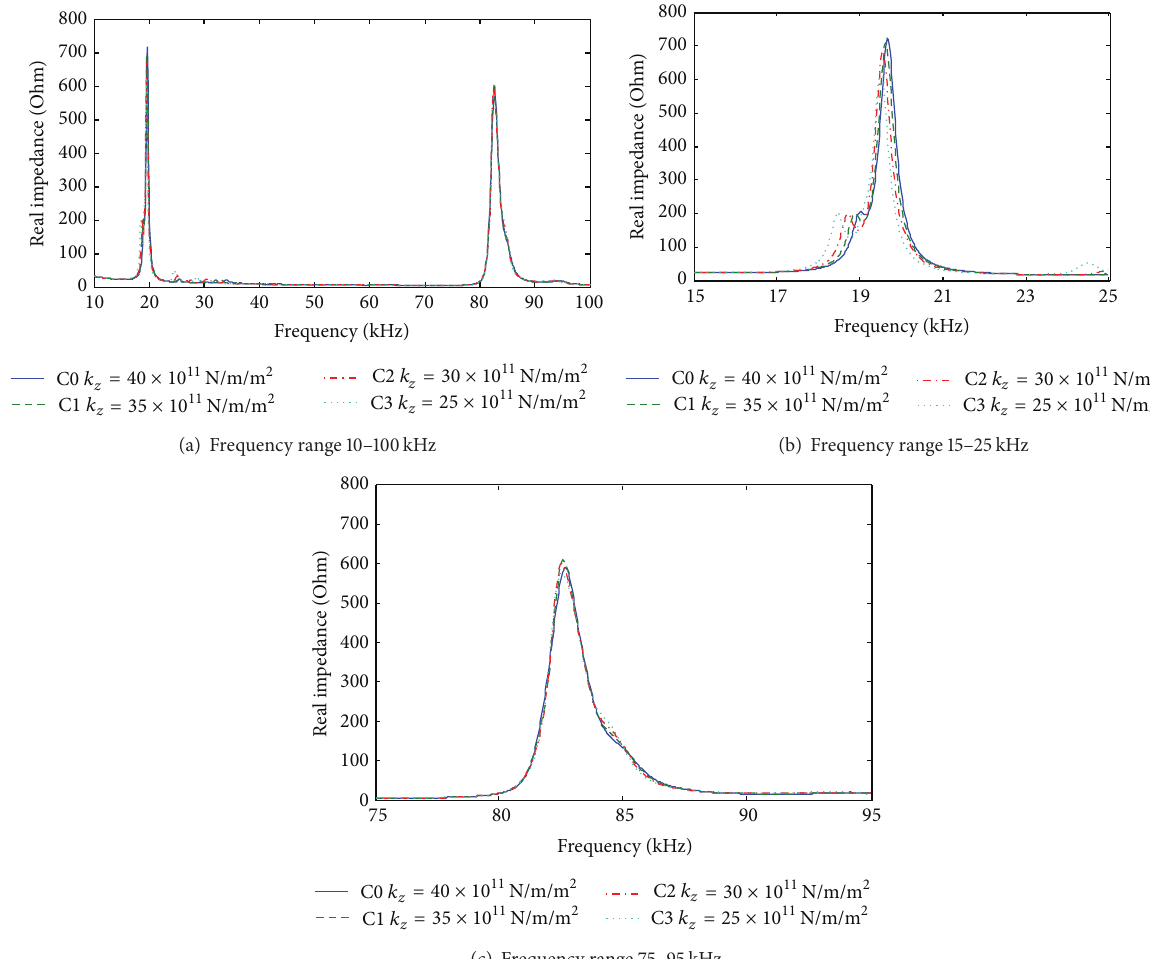
Figure 8: Impedance signatures of PZT-interface under various contact